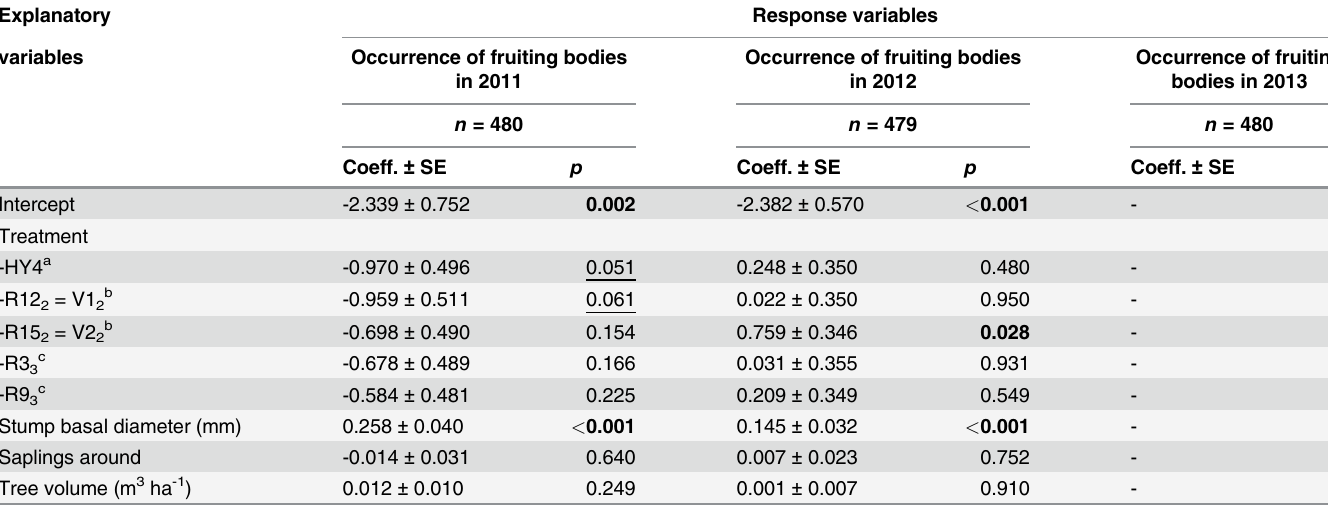
Table 7. Differences in the Occurrence of Fruiting Bodies in Birch Stumps between the C . purpureum Strain R5 3 and Other Treatments.